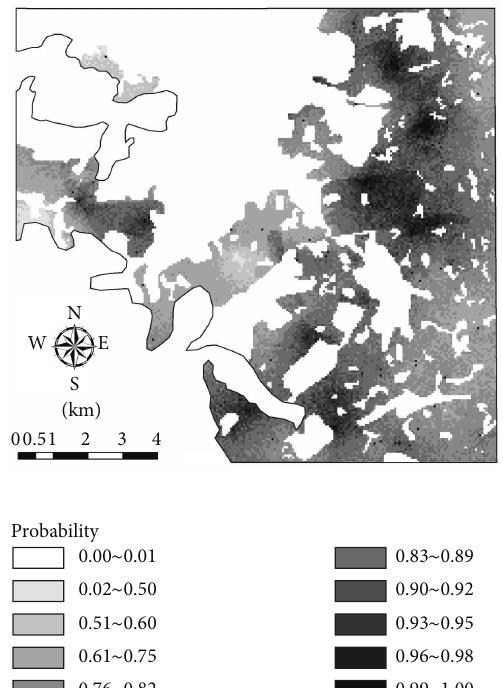
Figure 5: The probability map of Cd exceeding the composite soil environmental quality standard II of China for Cd in soil (referring to Table 1).